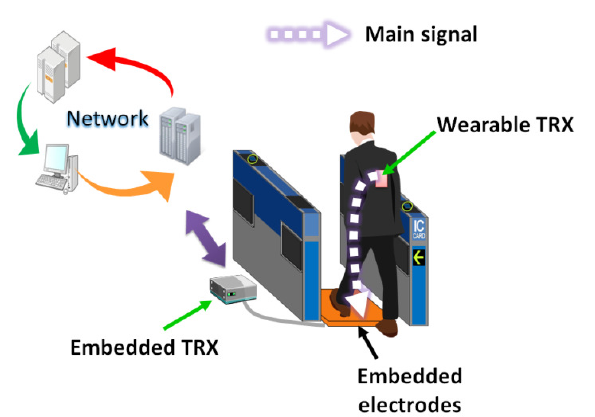
Figure 1. Hands-free ticket gate system using near-field coupling communication.